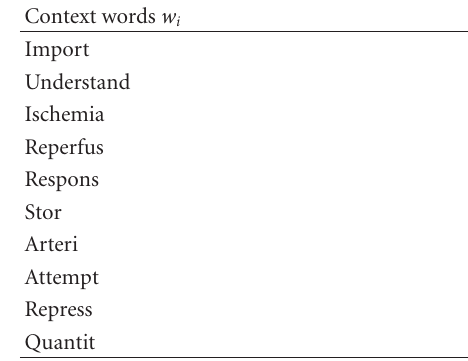
Table 2: Context words with the top MI values for the ambiguous word “ cold